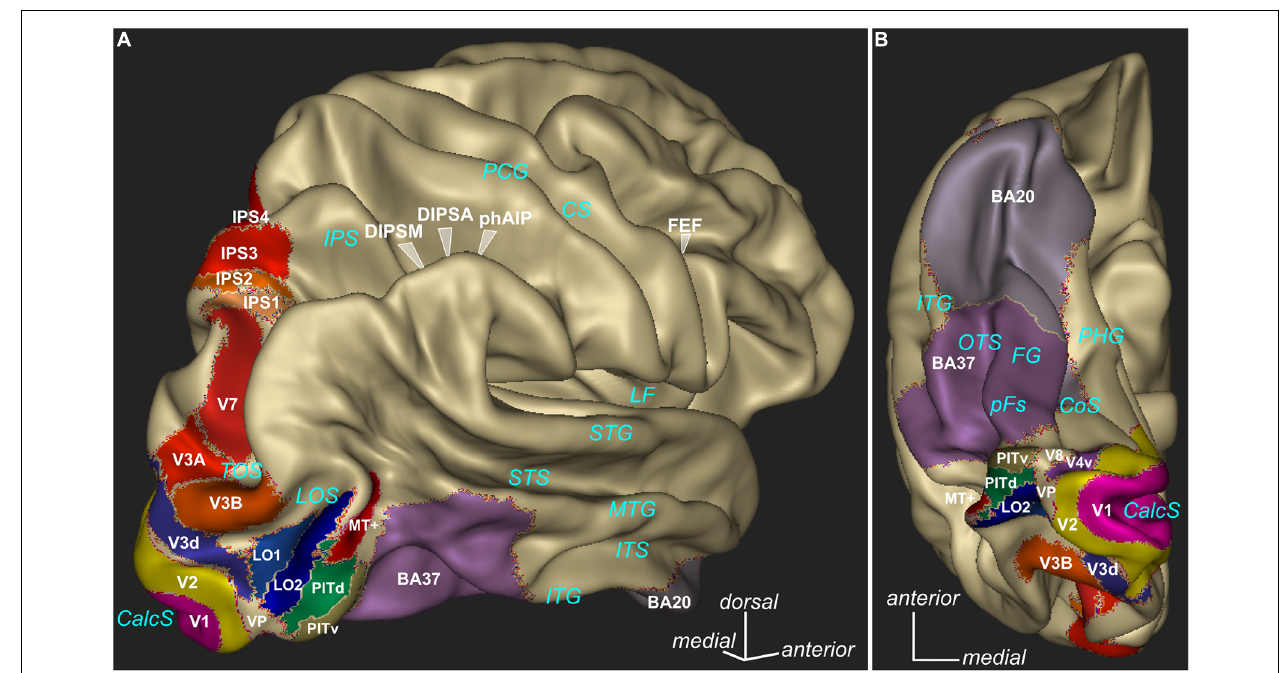
FIGURE 1 | Parcellation of different cortical regions involved in visual processing. Some of these regions are particularly involved in binocular vision and some regions are known to show deficits in amblyopes under diverse visual stimulation. Lateral view (A) and ventral view (B) are presented. The 3D rendering (Anatomist, www.brainvisa.info) represents the cortical surface of the Conte69 human surface-based atlas (Van Essen etal., 2012). V1, V2, MT + as defined by (Fischl etal., 2008), V3A, V3B, V4v, V7, IPS1/2/3/4 as defined by (Swisher etal., 2007), V3d, LO1, LO2, PITd, PITv,